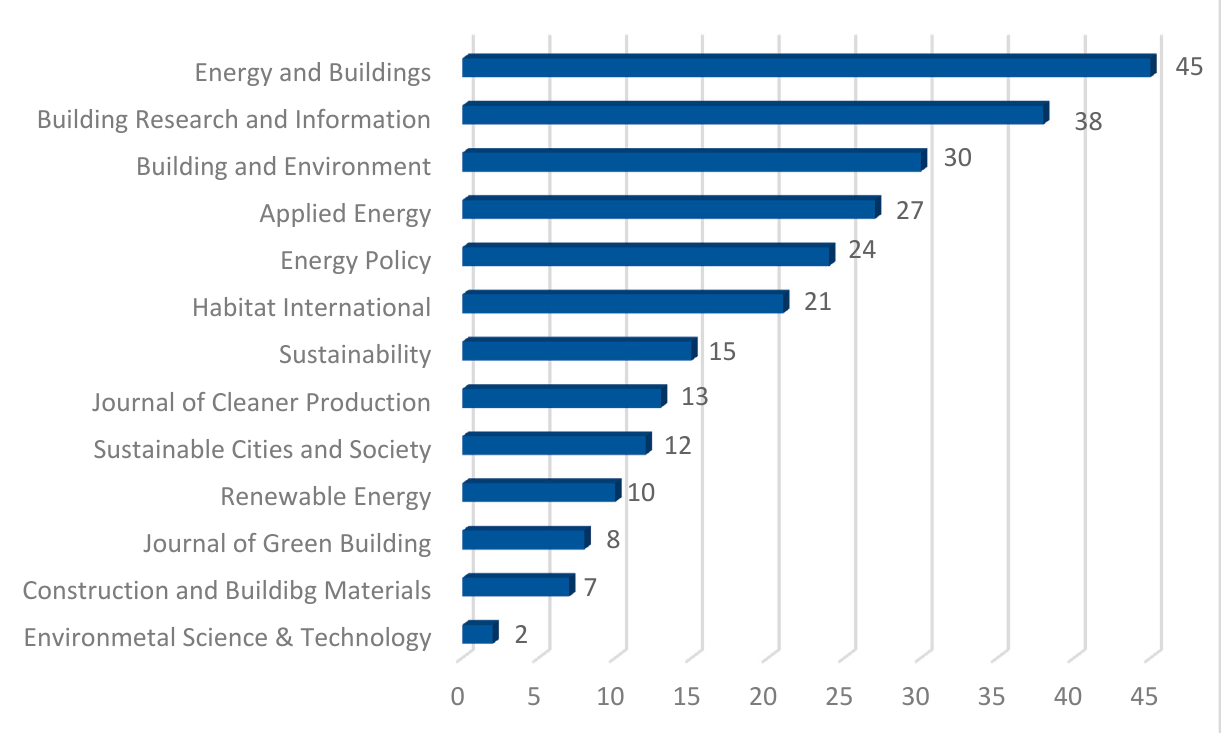
Figure 4 illustrates the geospatial distributions of research publications.